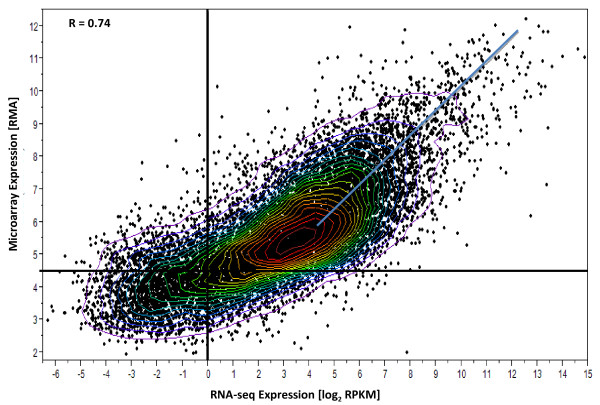
Comparison of Gene Expression Measurements by Two Methods. Gene Microarray expression level (RMA) vs. RNA-seq expression level (log2 RPKM) for subject C3. Both axes are expressed in base 2 logarithmic scale. The dynamic range (ratio of largest observable value to apparent background value) of the RNA-seq data is clearly larger than that of Exon array data. Bivariate density contours indicate a strong but nonlinear correlation between the two measurements. The two methods yield nearly proportional results above the median expression levels (Blue line). Solid Black lines are detection limits for microarray (RMA = 4.5) and RNA-seq (log2RPKM =0). Refer Methods for the description of detection limits.